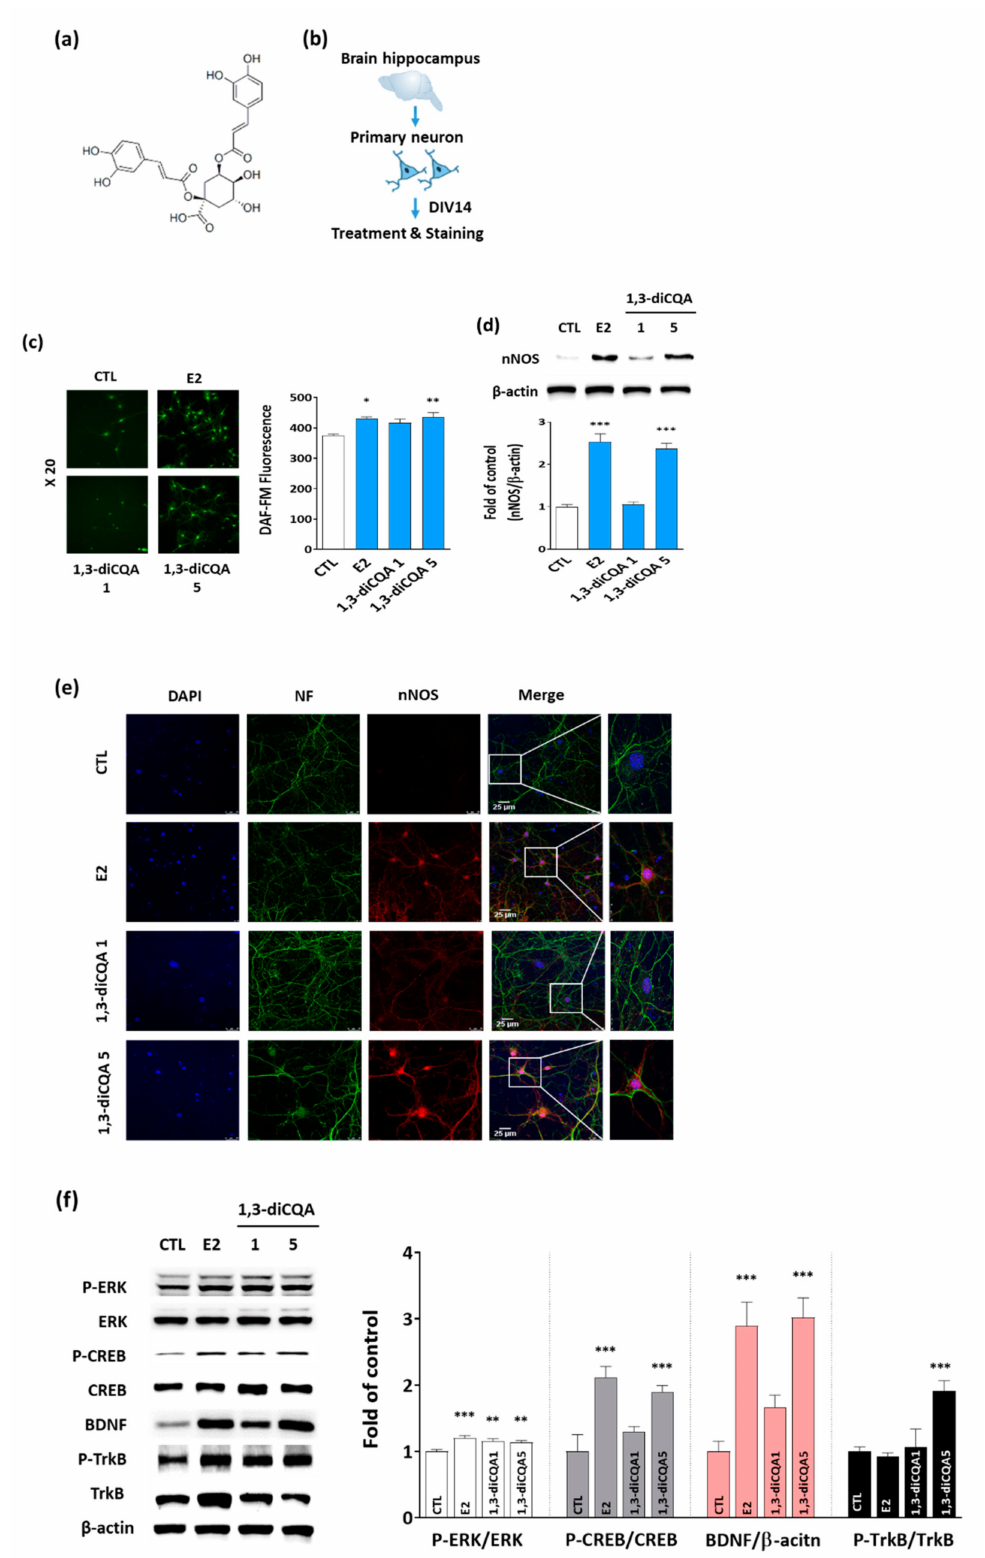
Figure 5. 1,3-diCQA as an active compound from AE upregulates nNOS expression and the ERK– CREB–BDNF signaling pathway in primary hippocampal neuron. ( a ) Structure of 1,3-diCQA. ( b ) Schematic of primary hippocampal neuron culture and treatment. ( c ) Cultured hippocampal neuronal cells stained with fluorescent NO indicator DAF-FM DA for 30 min. NO abundance